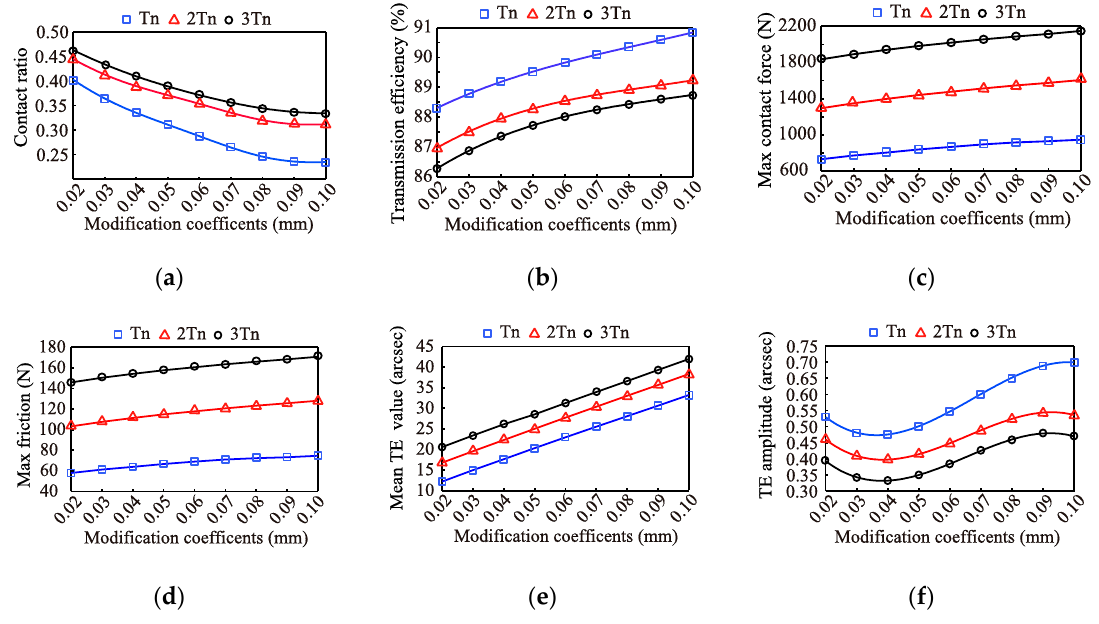
Figure 12. Effect of case 1 modification method on the transmission performance of RV reducer: ( a ) contact ratio, ( b ) transmission efficiency, ( c ) max contact force, ( d ) max friction, ( e ) mean TE value, and ( f ) TE amplitude.